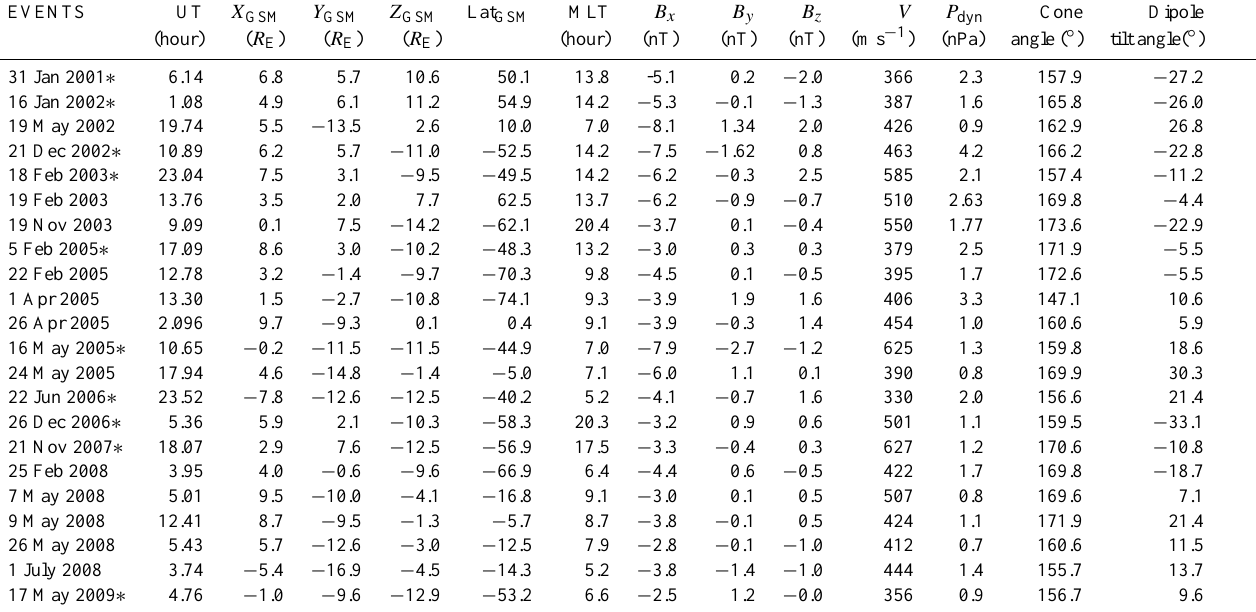
Figure 3. Orbital tracks of Cluster 3 in the framework of the Shue98 magnetopause model in the GSM coordinate system from 10 to 20:00UT on 19 May 2002. Two views in both x − y and x − z planes are shown to clarify the location of C3 relative to the magnetopause. The opaque planes depict the magnetopause from the Shue98 model at 19:45 UT, and C3 is located outside the predicted magnetopause, as indicated by the red dot. Table 1. The corresponding parameters for magnetopause crossings during earthward RIMF (IMF B x < 0). Event date, time (UT), Cluster position in the GSM coordinate system, latitude, magnetic local time (MLT), difference between the observed and modeled magnetopause position, corresponding solar wind and IMF parameters, IMF B x , B y , B z , solar wind velocity ( V ), dynamic pressure ( P dyn ), IMF cone angle, and dipole tilt angle are given from left to right. The midlatitude crossings are marked with asterisks.